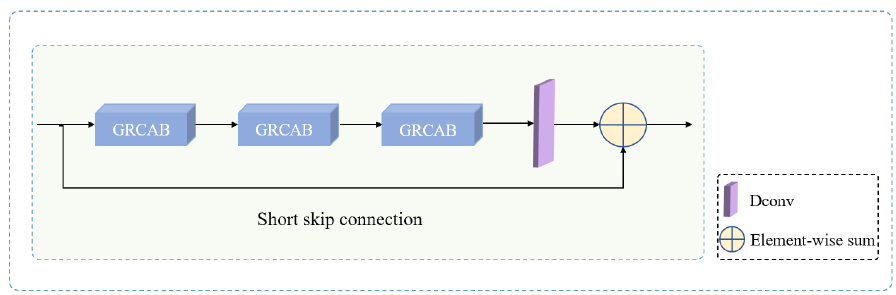
Figure 2. The improved residual learning module (GSRiR).